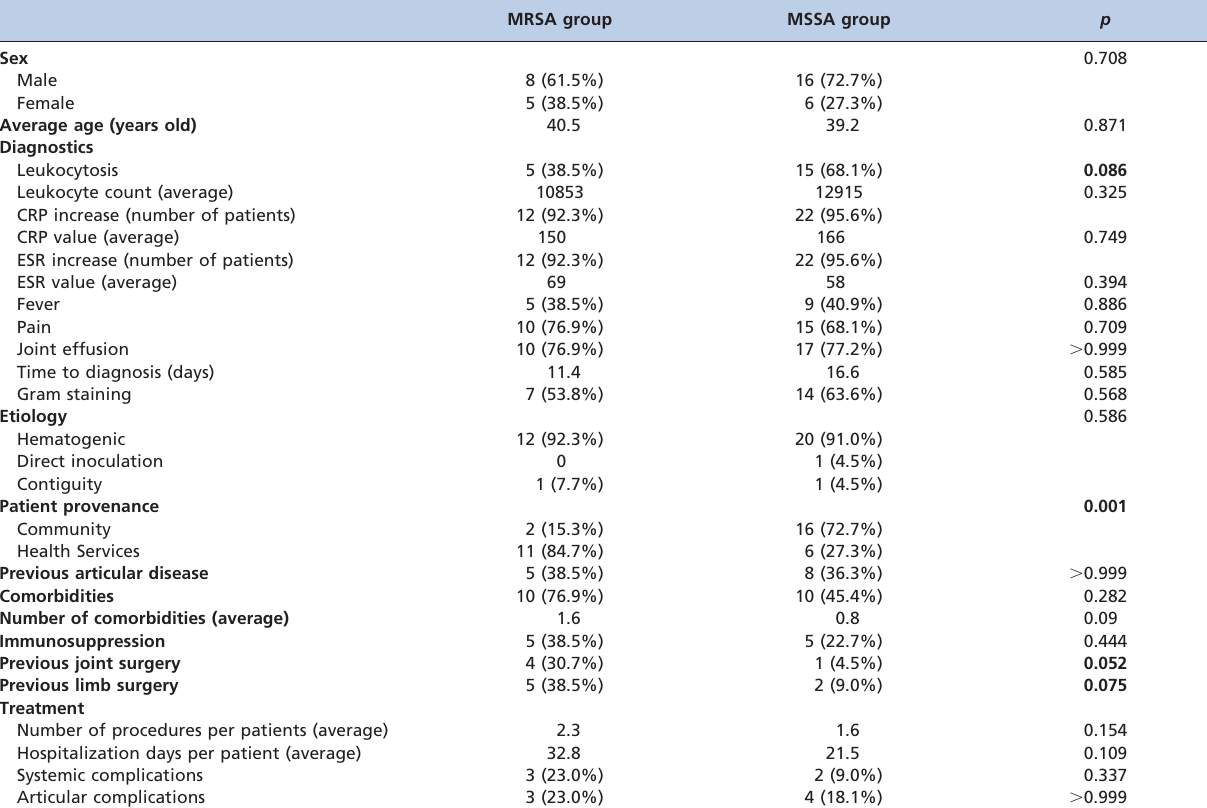
Table 1 - Clinical and epidemiological summary of study results and statistical analysis.